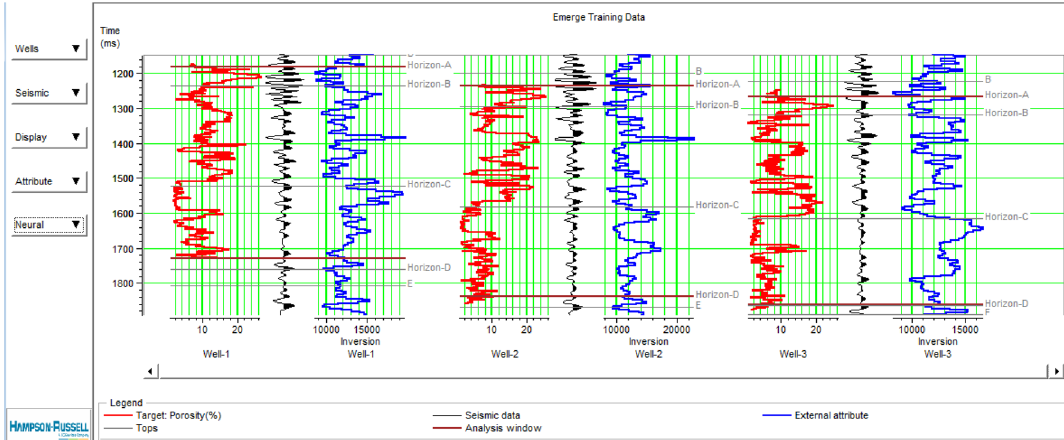
Fig. 13 Data imported to the software in the EMERGE section include the chart of the desired parameters from the wells (red), trace around the well (black), and results from inversion around the wells